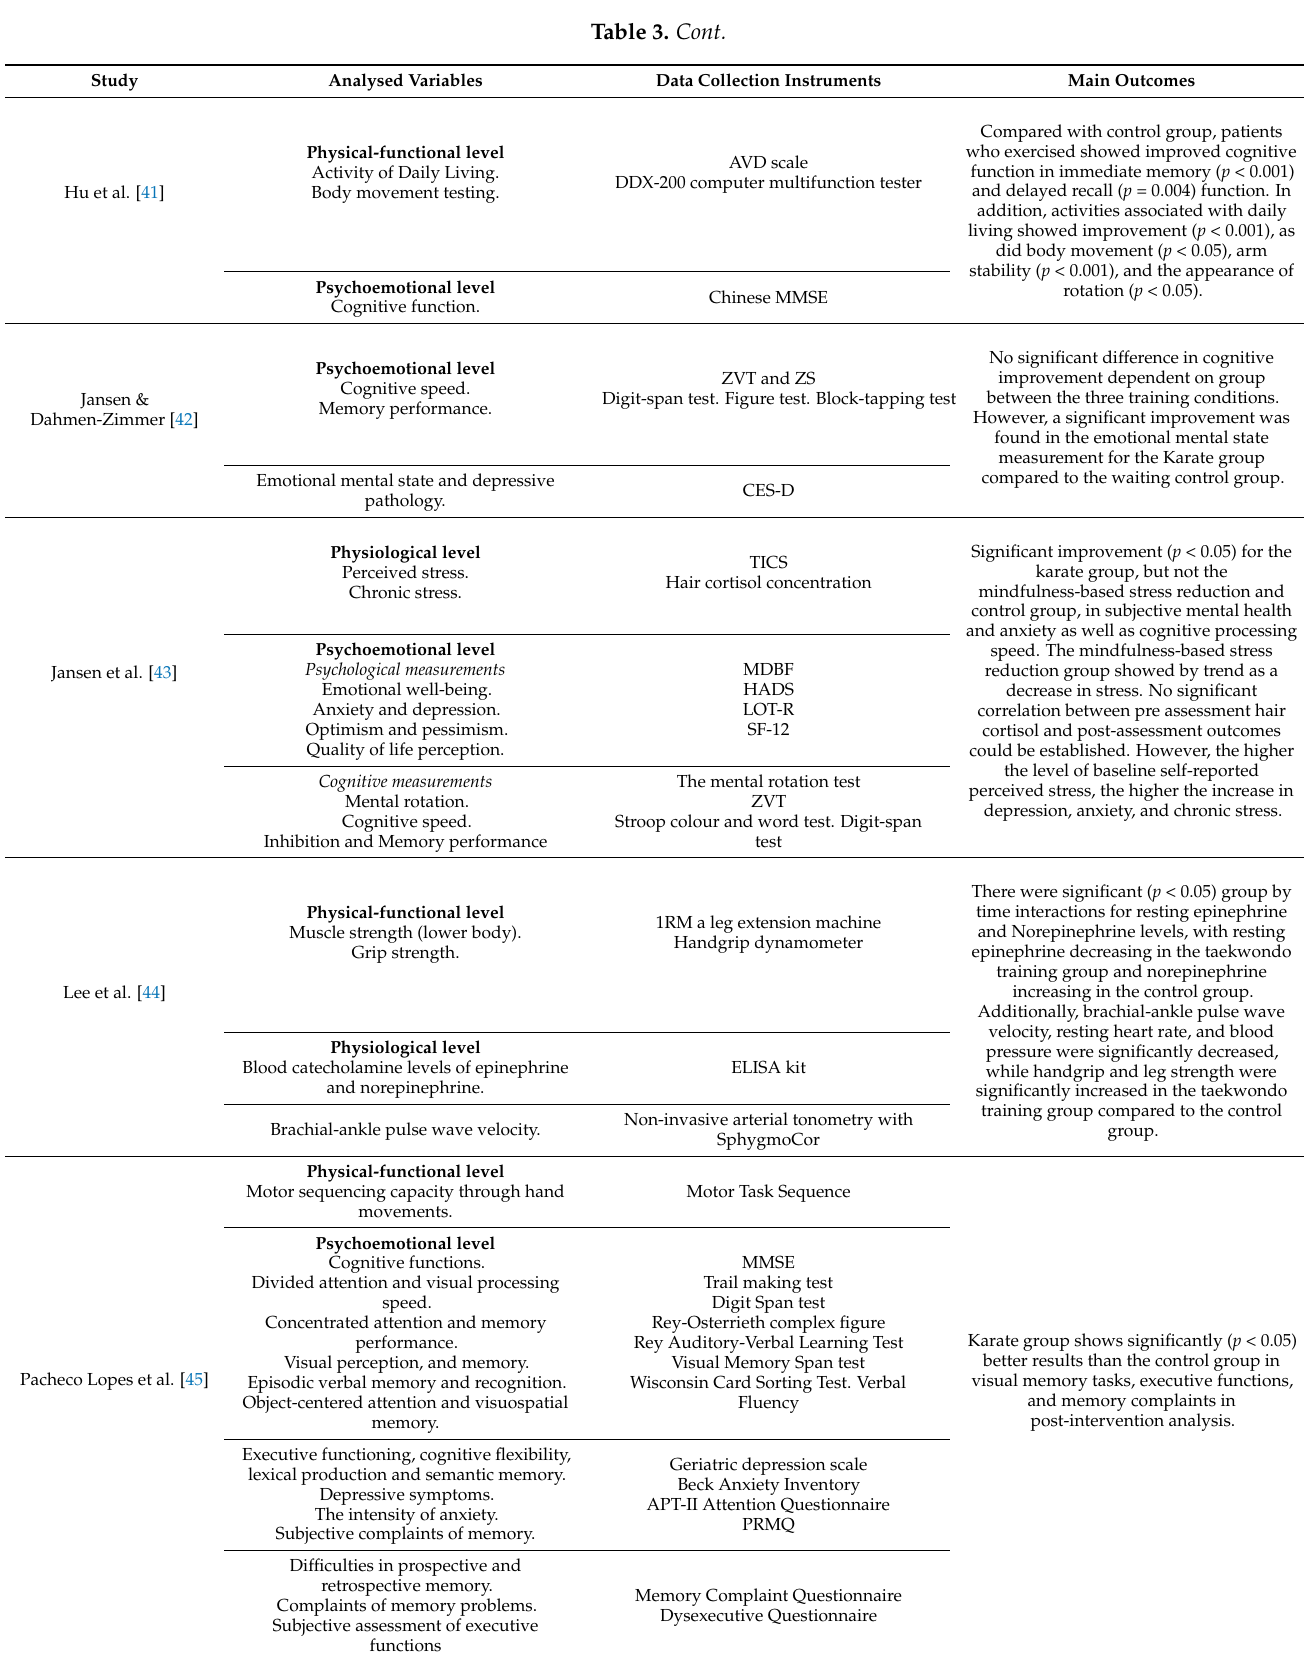
ZVT and ZS Digit-span test. Figure test. Block-tapping